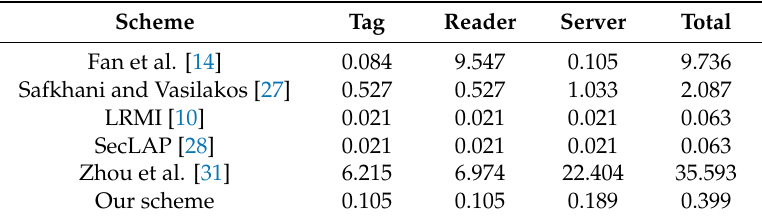
Table 5. Computation cost comparison (in